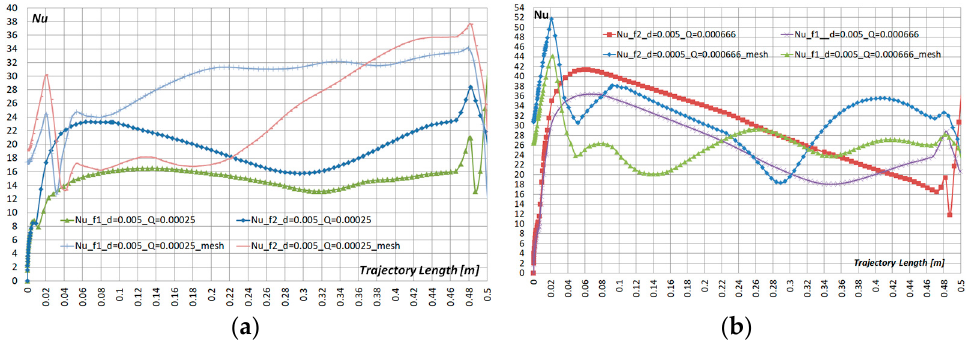
Figure 8. Heat transfer coefficient Nu , d = 500 µm: ( a ) Q = 0.00025 m 3 /s; ( b ) Q = 0.000666 m 3 /s.